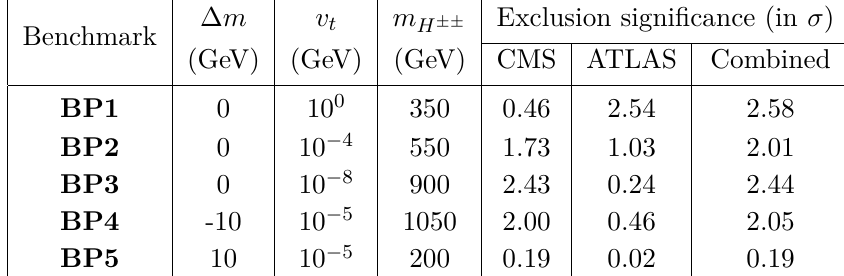
Table 1 . Benchmark points and exclusion